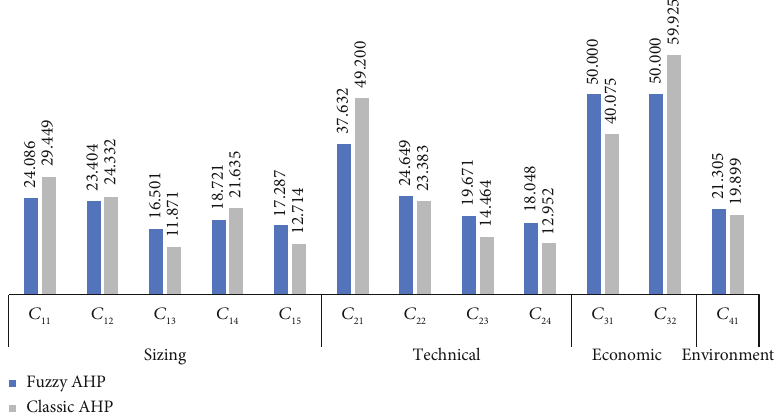
Figure 10: Priority weight of subcriteria.